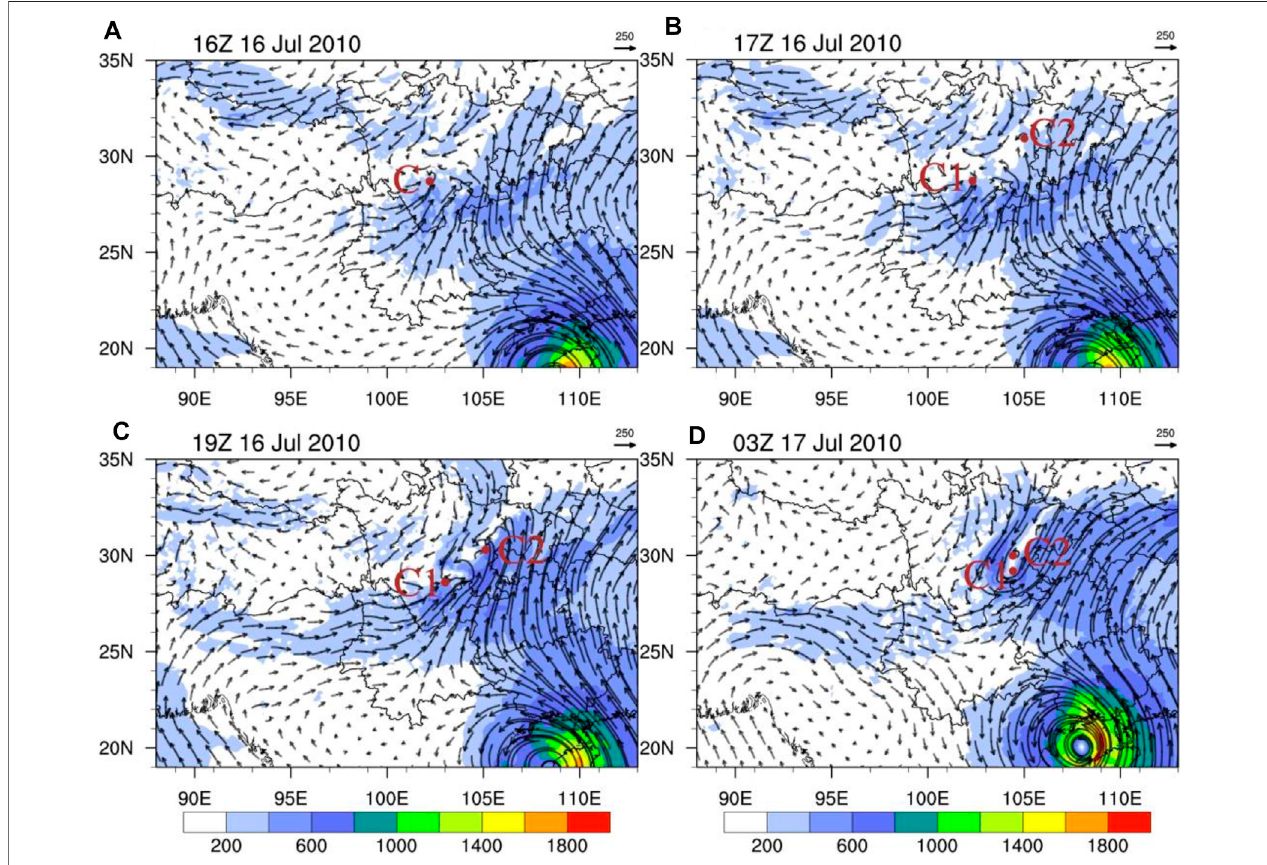
FIGURE10| Vertical integration ofwatervapor fl uxes from 1,000to 300 hPa(shadingsand arrows, unit: kg m − 1 s − 1 )by theCTL experiment at (A) 16:00 UTC July 16, (B) 17:00 UTC July 16, (C) 19:00 UTC July 16, and (D) 03:00 UTC July 17.